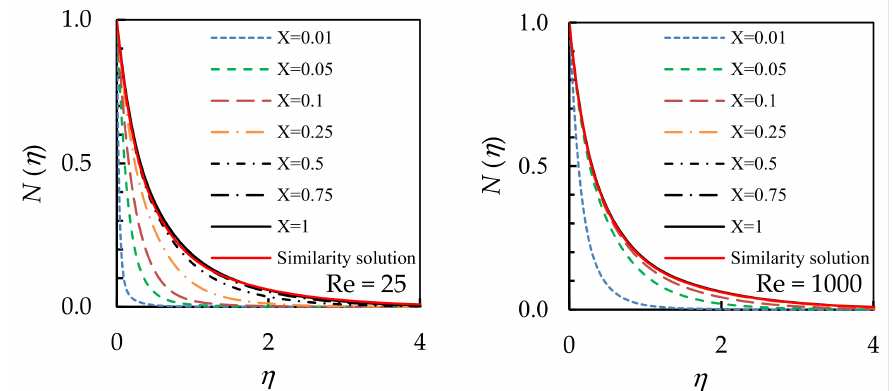
Figure 6. Effect of the Reynolds number on the density of the gyrotactic microorganism profiles at various locations along the sheet for Gr = 10 4 , Pr = 6.2, Le = 10, Nb = Nt = Nr = Rb = Ω = 0.1, and Pe = Lb = 1.